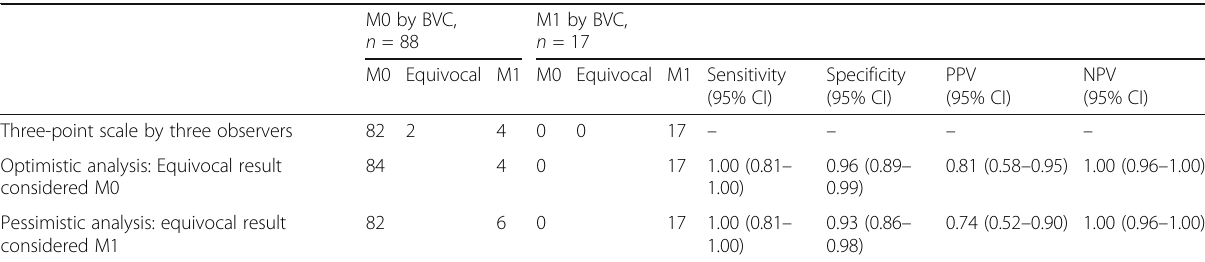
Table 2 Diagnostic accuracy of 68Ga-PSMA PET/CT among 105 patients with a final diagnosis (BVC) for the presence or absence of bone metastases